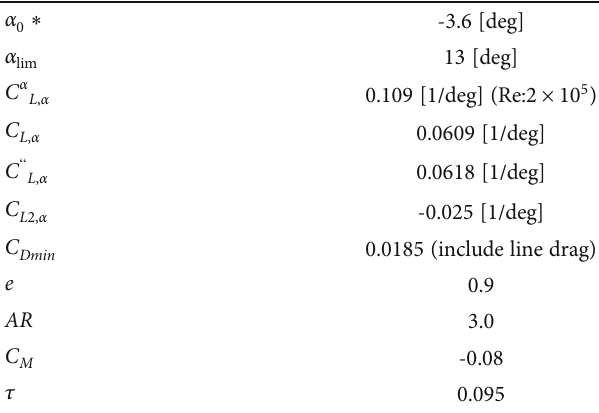
Table 1: Aerodynamic parameters.